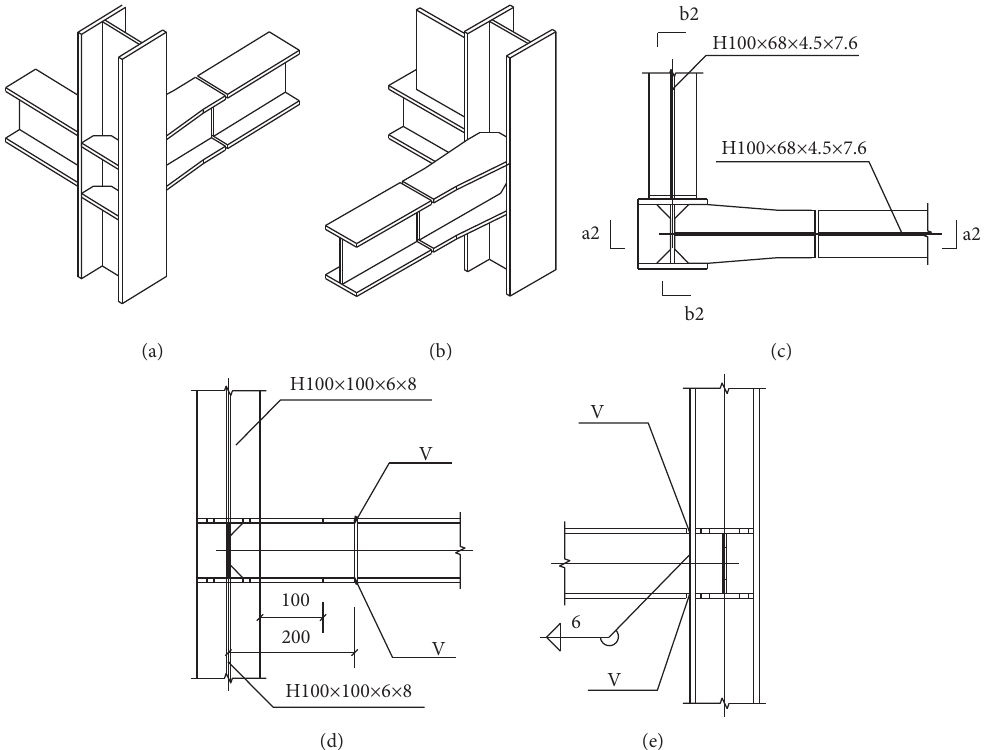
Figure 2: Beam-column connection. (a) 3D connection of the pure frame. (b) 3D connection of the BRB frame. (c) Plane of connection. (d) Section a2-a2. (e) Section